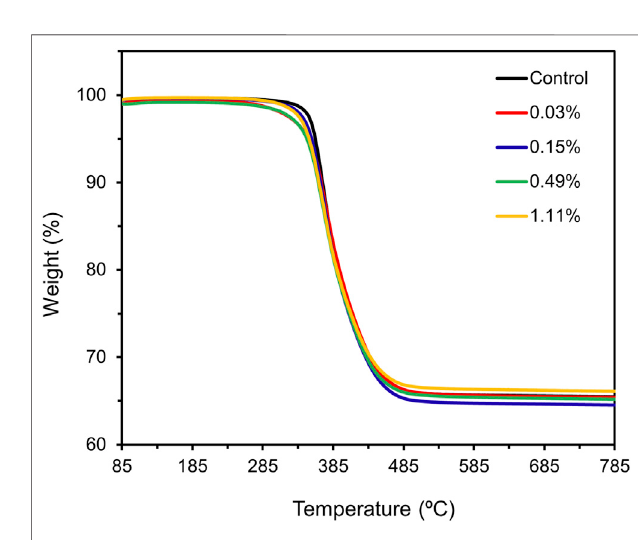
FIGURE 6 | Thermogravimetric analysis for GFRP composites with different GNP